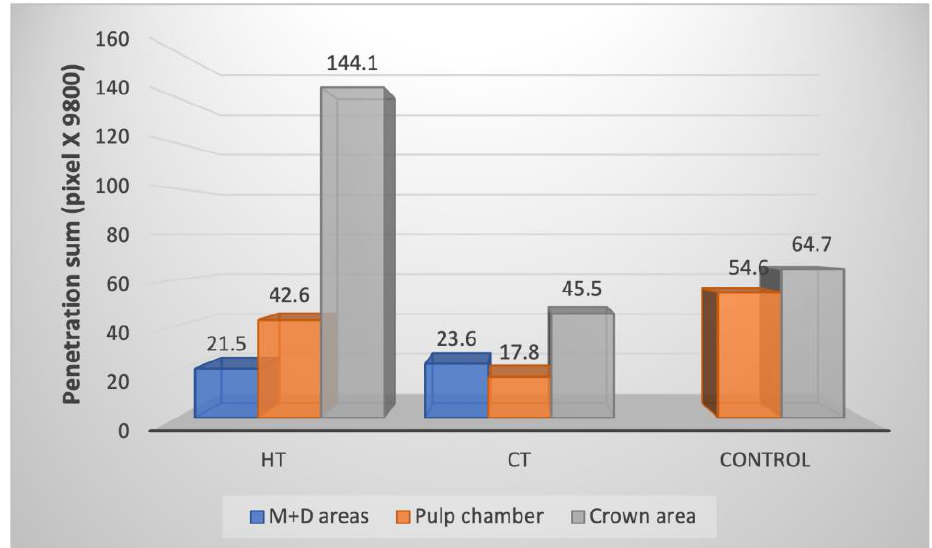
Figure 5. Comparison of total bacterial distribution among the different parts of the tooth and by experimental group. Abbreviations: CT, conventional technique; HT, Hall technique; M + D, mesial and distal.